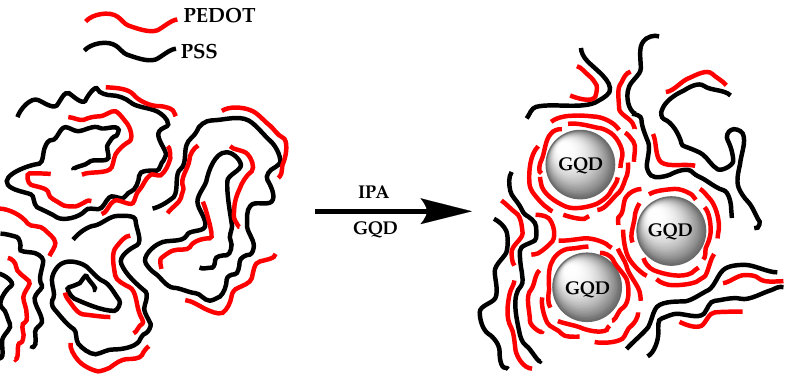
Figure 9. Schematic representation of the core-shell nanostructures (CSNS) formation of the GQD@PEDOT. Reprinted with the permission of Reference [97]. Copyright 2015 American Chemical Society.